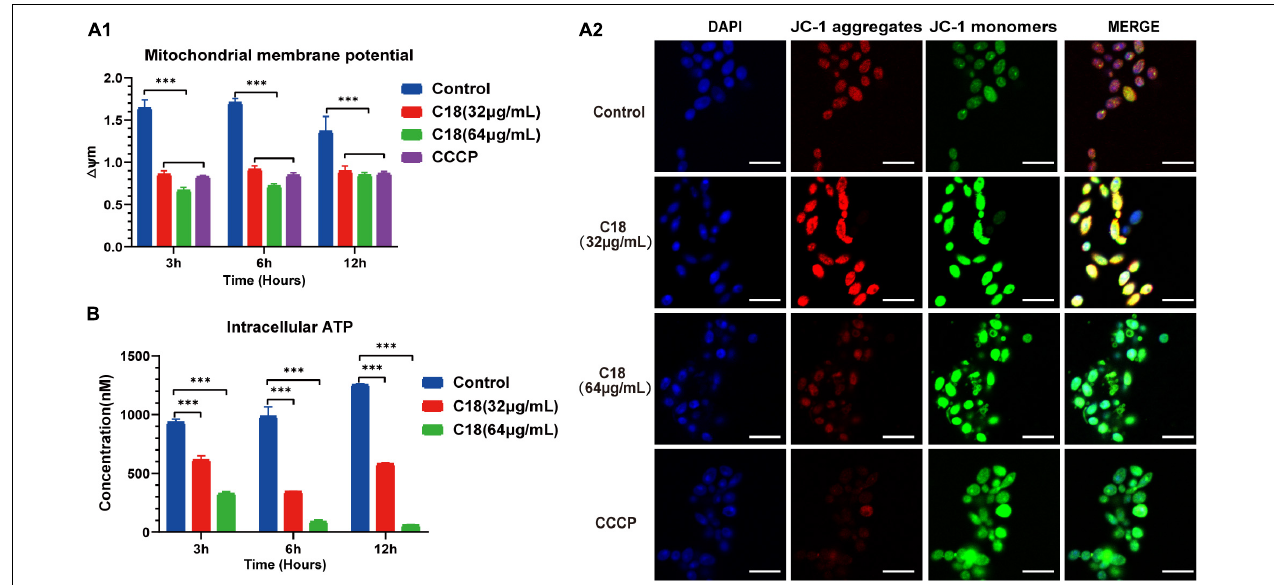
FIGURE 8 | Mitochondrial Dysfunction of Candida albicans treated with or without C18. (A1) (cid:52) (cid:57) m of C. albicans was measured by 5,5 (cid:48) ,6 (cid:48) ,6 (cid:48) -terachloro-1, 1 (cid:48) 3,3 (cid:48) -tetraethyl-benzimidazolyl carbocy-anine iodide (JC-1) staining in the presence or absence of 32 µ g/ml or 64 µ g/ml C18 for 3 h, 6 h, and 12 h. Bar diagram showed the ratio of red fluorescence intensity to green fluorescence intensity ( (cid:52) (cid:57) m) detected by sectrofluoro-photometer. Carbonyl cyanide m-chlorophenyl hydrazine (CCCP), a mitochondrial uncoupler, can depolarize (cid:52) (cid:57) m of cells and was used as the positive control. The results are presented as mean ± SD of three independent experiments. ∗∗∗ p < 0.001, compared to the control group. (A2) Fluorescence images of C. albicans cells stained by DAPI and JC-1 after C18 treatment for 6h was captured by CLSM. Blue represents cell nucleus while red fluorescence represents JC-monomers, and green fluorescence represents JC-aggregates. The color of merged images reflects the degree of (cid:52) (cid:57) m loss. Scale bar 10 µ m. (B) Intracellular ATP of cells were measured by sectrofluoro-photometer. The results are presented as mean ± SD of three independent experiments. ∗∗∗ p < 0.001, compared with the control